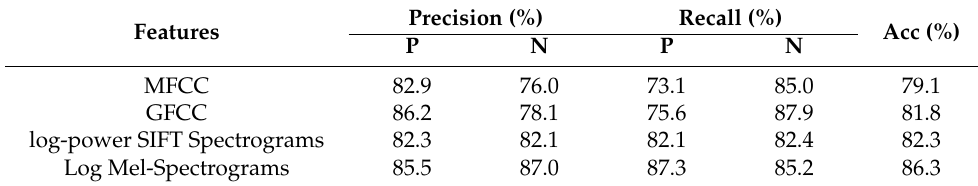
Table 2. The performance of our RANet with different features. Mel-frequency cepstral coefficients (MFCC), gammatone frequency cepstral coefficients (GFCC), and short time fourier transform (STFT).